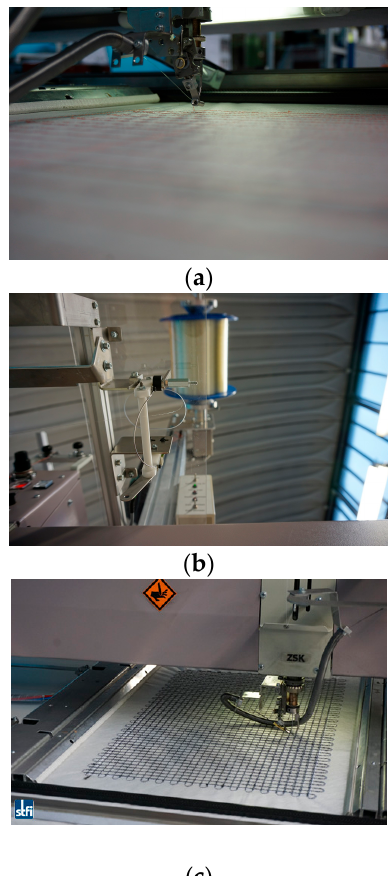
Figure 4. Embroidery machine that was modified in order to simultaneously process carbon filaments and optical fibers. The modification included the development of an appropriate embroidery needle ( a ) and a mechanism to auto-track the optical fiber during fabrication of the FCS ( b ) to process the carbon filaments and optical glass fiber simultaneously on a nonwoven substrate made of PVA ( c ).